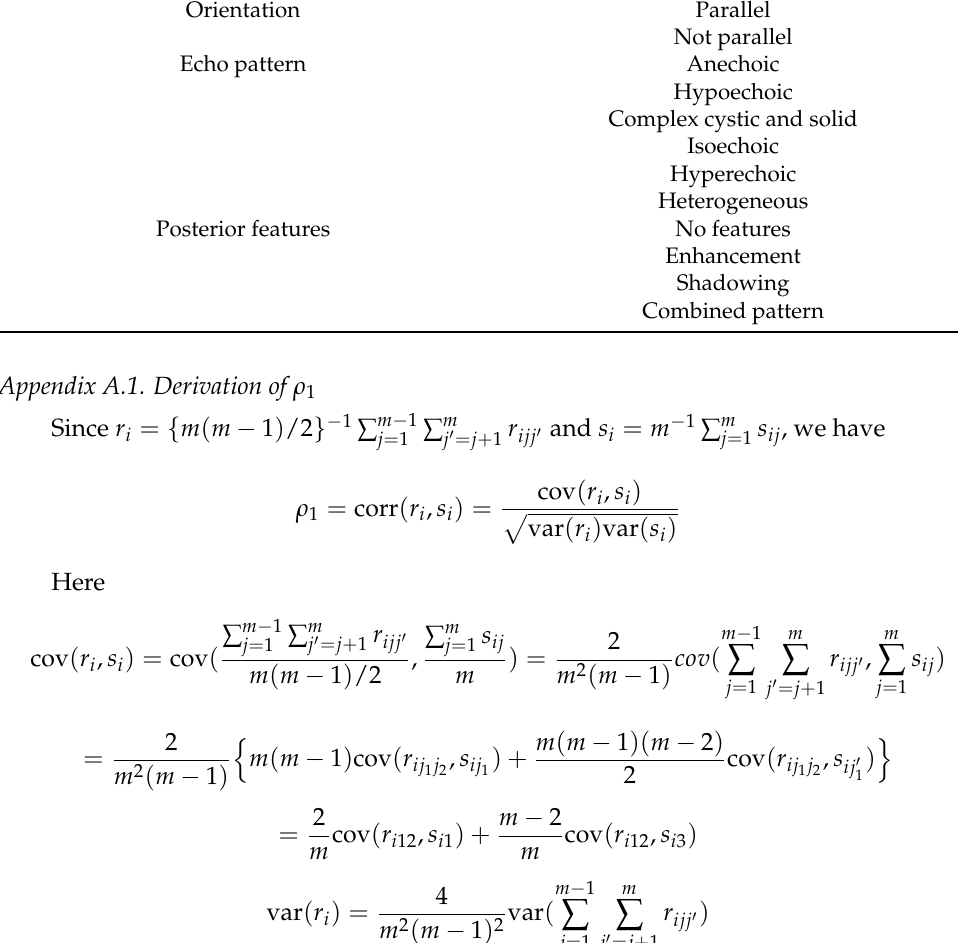
Table A1. Examples of ultrasound lexicon. Ground Truth Lesion Type Shape Oval Margin Circumscribed Orientation Parallel Echo pattern Anechoic Posterior features No features